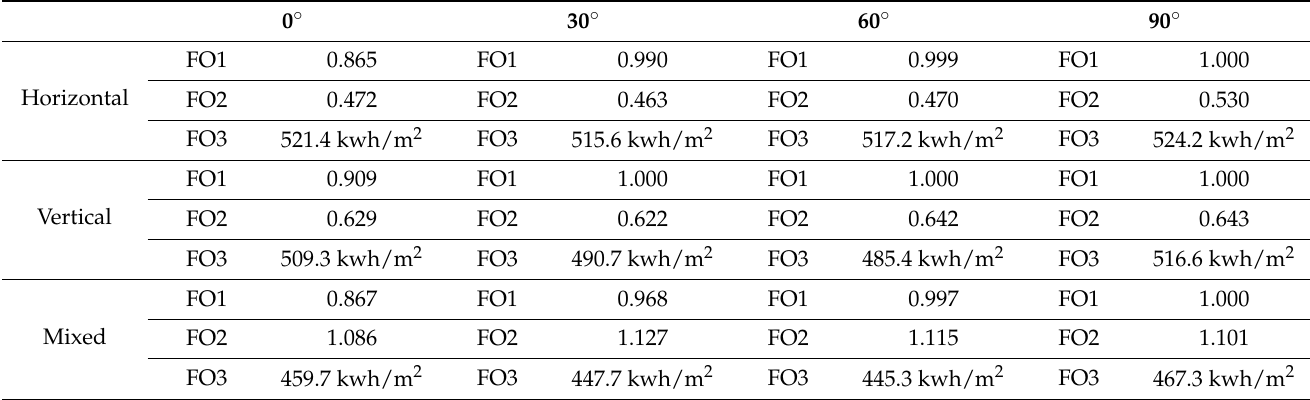
Table 3. The maximum values of each objective in multiple orientations in three additional